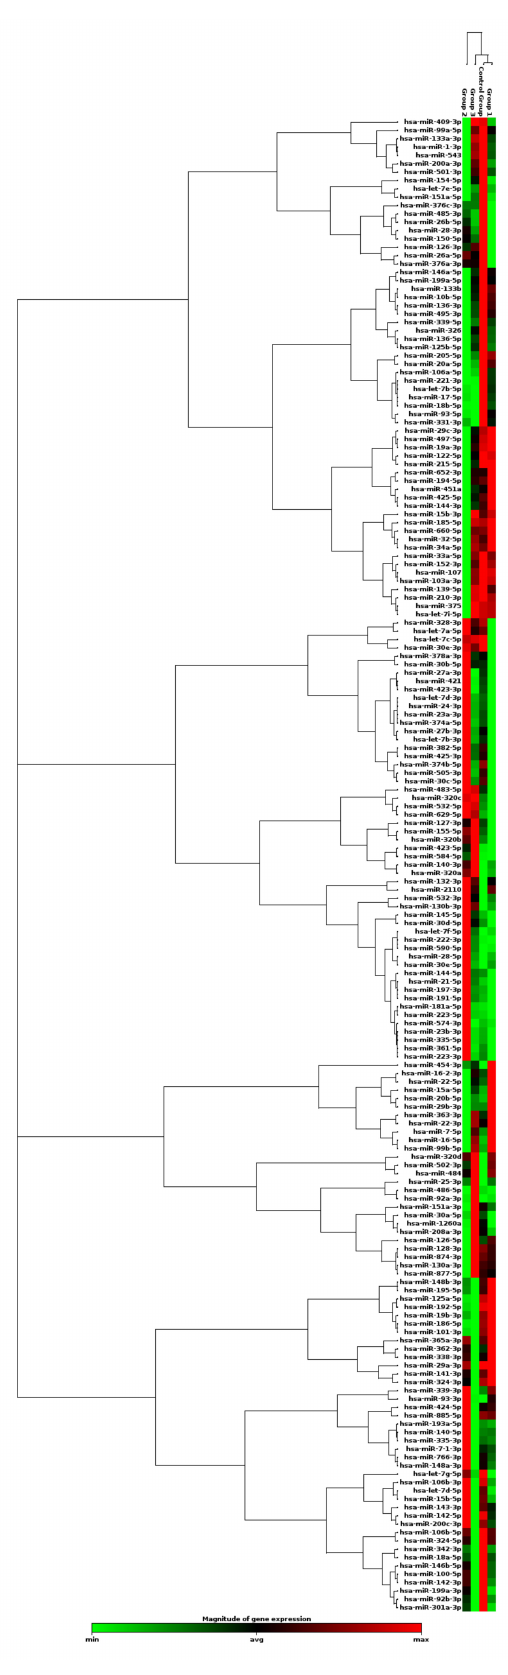
Figure 2. Clustergram indicating the magnitude of miRNA expression (green = minimal, red = maximal). Clustering is grouped by cohort (control group = healthy non-smokers, group 1 = healthy smokers, group 2 = lung cancer and group 3 = stable